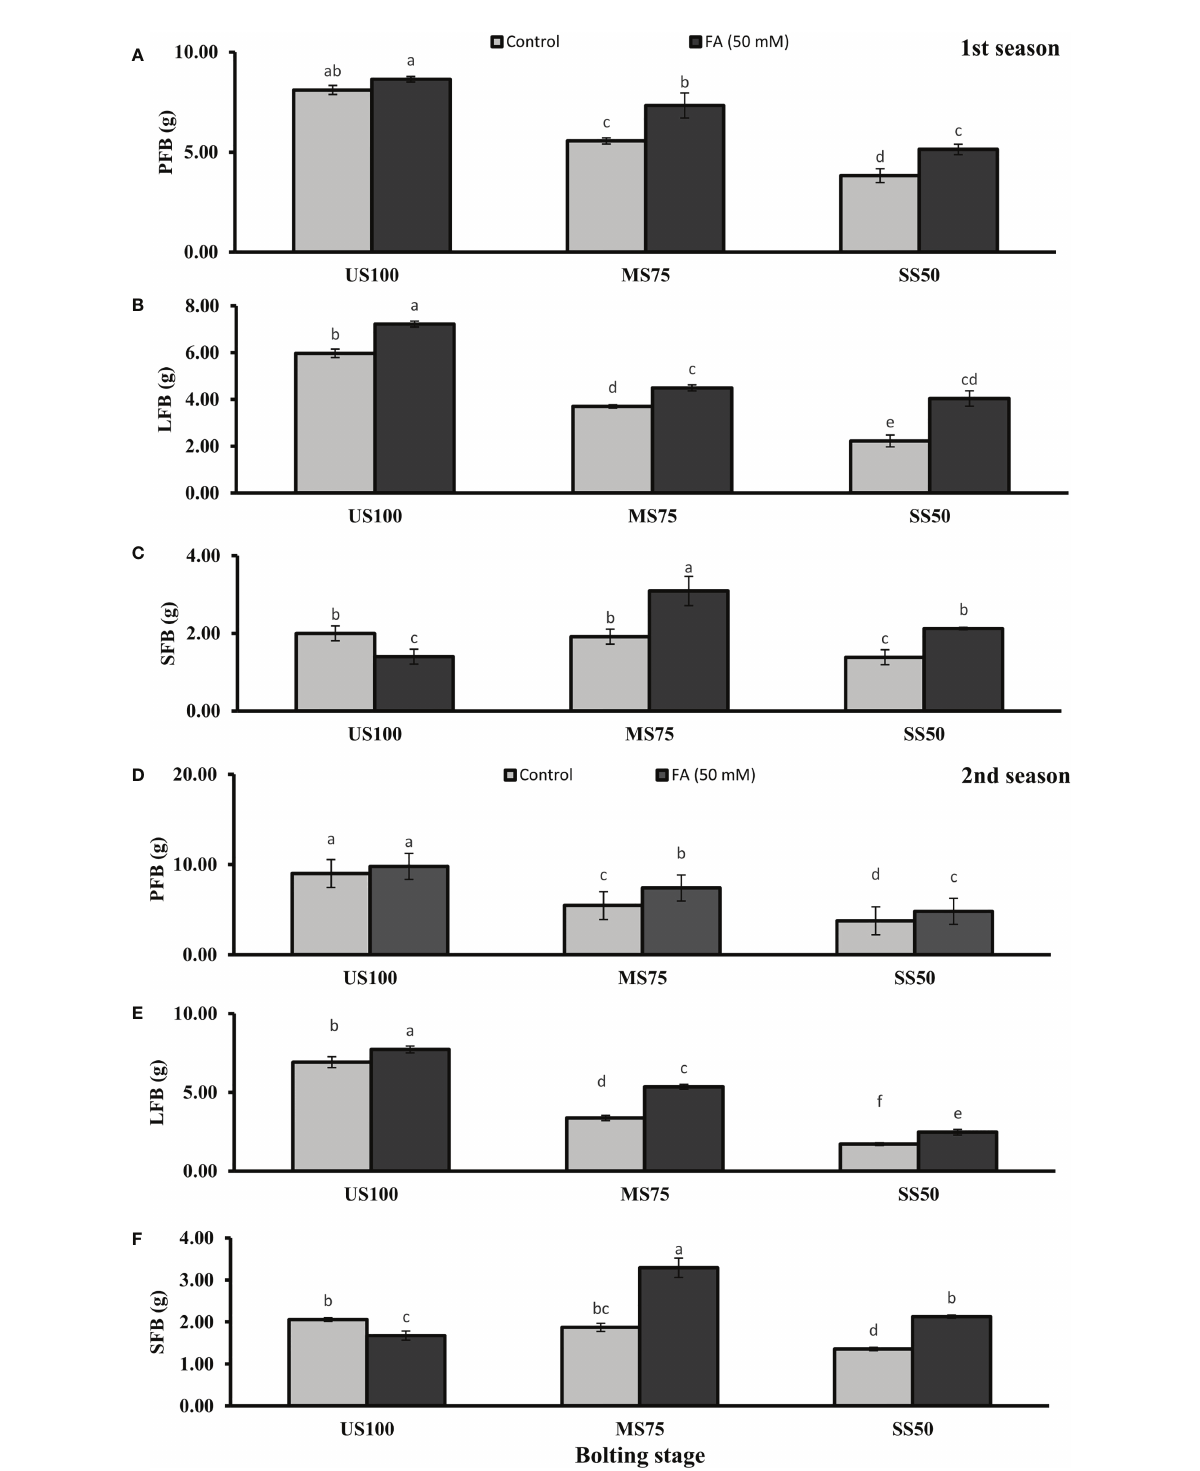
FIGURE 3 Effect of foliar application of folic acid (50mM) at bolting stage on (A, D) plant fresh biomass/plant, (B, E) leaf fresh biomass/plant, and (C, F) shoot fresh biomass in the fi rst and second seasons. The graph values are the mean ± SE of four replicates. The bars exhibited with different letters indicate a signi fi cant difference between samples by least signi fi cant difference ( p ≤